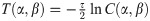
This UPGMA tree is obtained from the 1035 genealogical distances T(α,β)=-τ2lnC(α,β) between all pairs which can formed by 46 Romance languages spoken in the Italian peninsula, Iberian peninsula and Southern Gaul.According to our evaluation these Romance languages started to separate each other between 2121 and 2033 years BP. This range for the genealogical distance from the root to the leaves implies 5027 ≤ τ ≤ 5245. Notice that the main partition corresponds to the La Spezia–Rimini Line (also known as the Massa–Senigallia Line), which always seems quite mysterious for Italian native people.